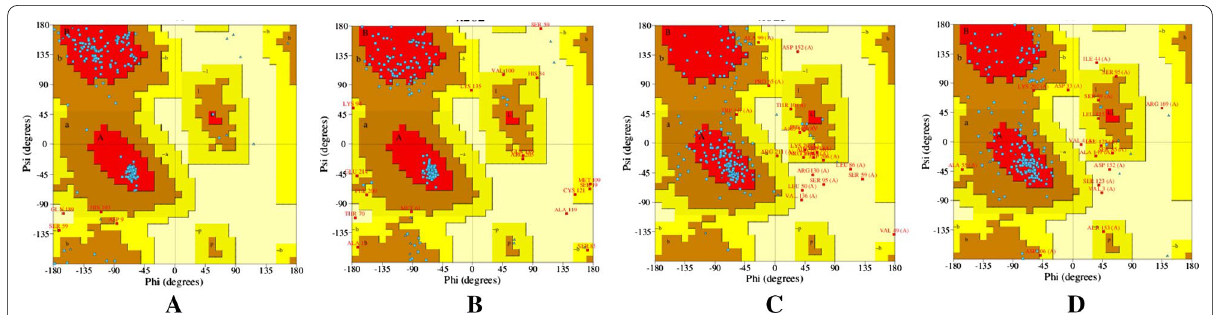
Fig. 7 The Ramachandran plots of the generated 3D models of Y-domain of HEV showing the favoured region s: ( A ) RaptorX; ( B ) Phyre2; ( C ) I-TASSER (model 1); and ( D ) I-TASSER (model 5). The analysis was conducted using PROCHECK